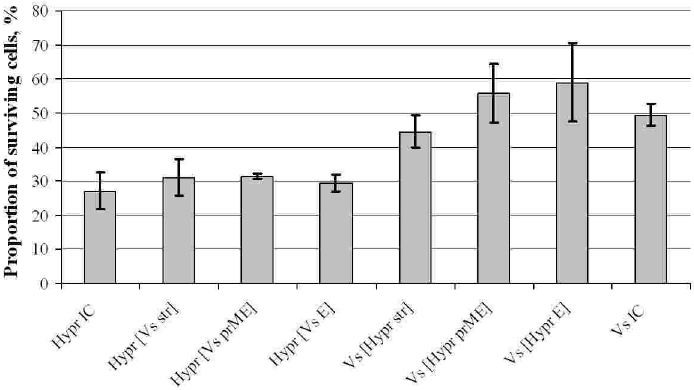
Fig 4. TBEV cytopathic effect in porcine kidney cells. Confluent monolayers of PS cells were infected at an moi of 1, in at least 4 replicates and incubated for 96 hours followed by staining with crystal violet and quantification of viable cells (grey blocks) as described in Materials and methods. Error bars reflect 95% confidence intervals.